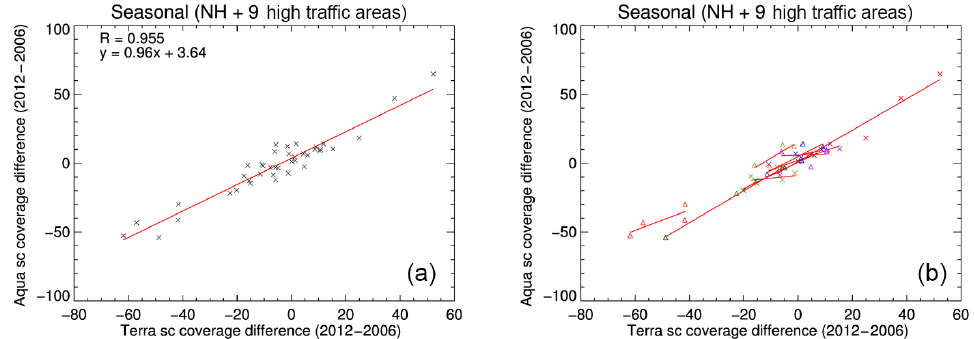
Figure 7. Scatter plots of relative difference ((2012–2006)/2006 × 100%) in Terra MODIS-derived CC versus Aqua-derived CC for each air traffic region. (a) Linear regression based on data from all 10 regions. (b) Linear regressions of each air traffic region: NH – blue crosses, N Atlantic – red crosses, CONUS – green crosses, Europe – dark yellow crosses, W Asia – purple crosses, E Asia – blue triangles, Europe–LA – red triangles, HI–CONUS – green triangles, NE Pacific – dark yellow triangles, NW Pacific – purple triangles.